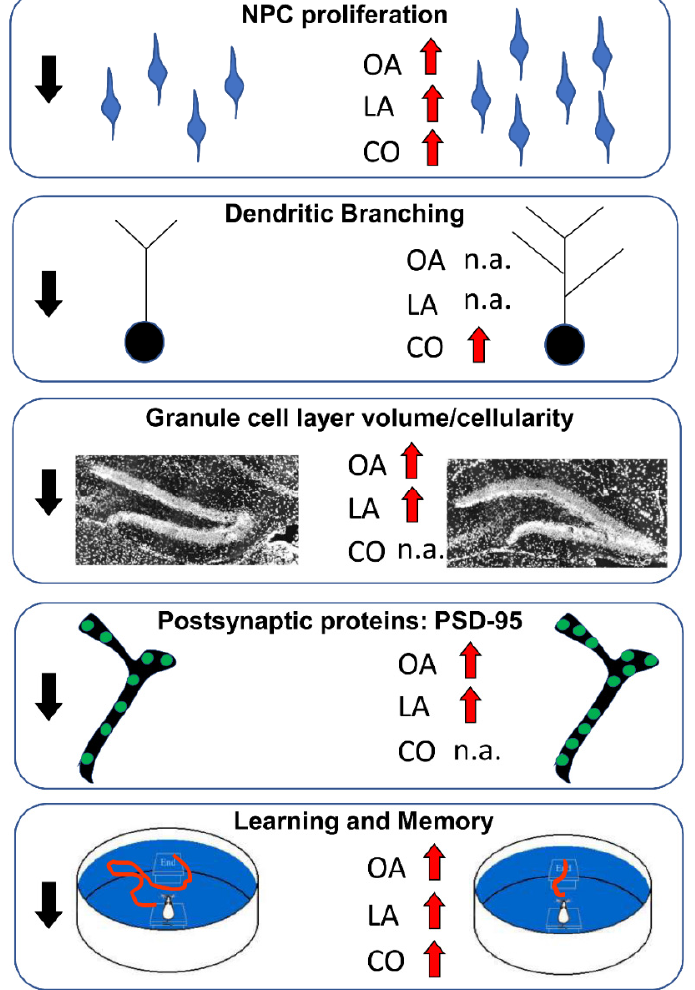
Figure 6. Summary of the effects of fatty acids on brain development in the Ts65Dn model of DS. The downward-pointing black arrows indicate trisomy-related impairment of the variables reported in each panel. The positive effects of treatment with fatty acids are indicated on the right by the upward-pointing arrows. See text for details. Abbreviations: CO, corn oil; LA, linolenic acid; n.a., not available; OA, oleic acid.